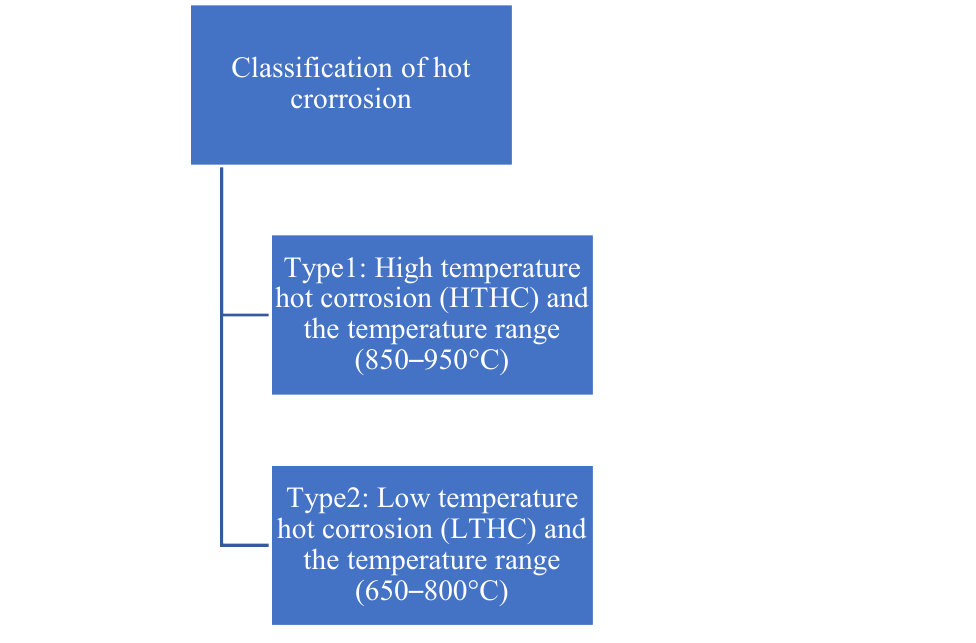
Figure 19. Classification of hot corrosion based on temperature.